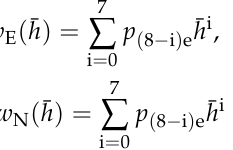
where w E and w N are the east wind speed and north wind speed, respectively. In order to keep the data at the 0 mean value, ¯ h = ( h − µ d ) / σ d is used as the independent variable for fitting, and µ d = 15,000 m and σ d = 8660.4 m. p ie and p in ( i = 1 ∼ 8 ) are the